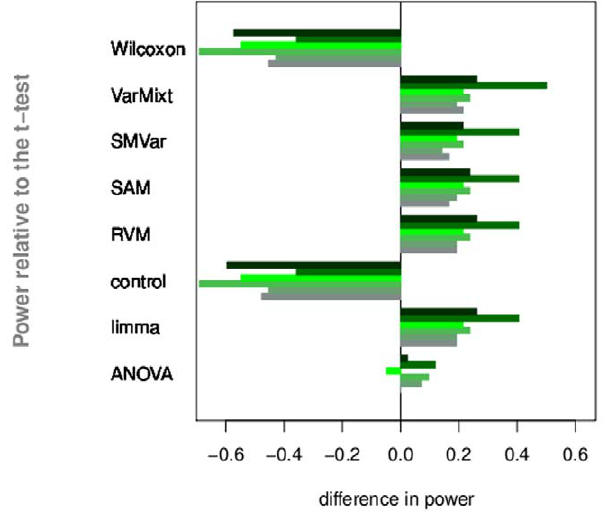
Figure 4. Spike-in data set. Power values are calculated at the 5% level and displayed according to six of the 13 pairwise comparisons. doi:10.1371/journal.pone.0012336.g004 PLoS ONE |